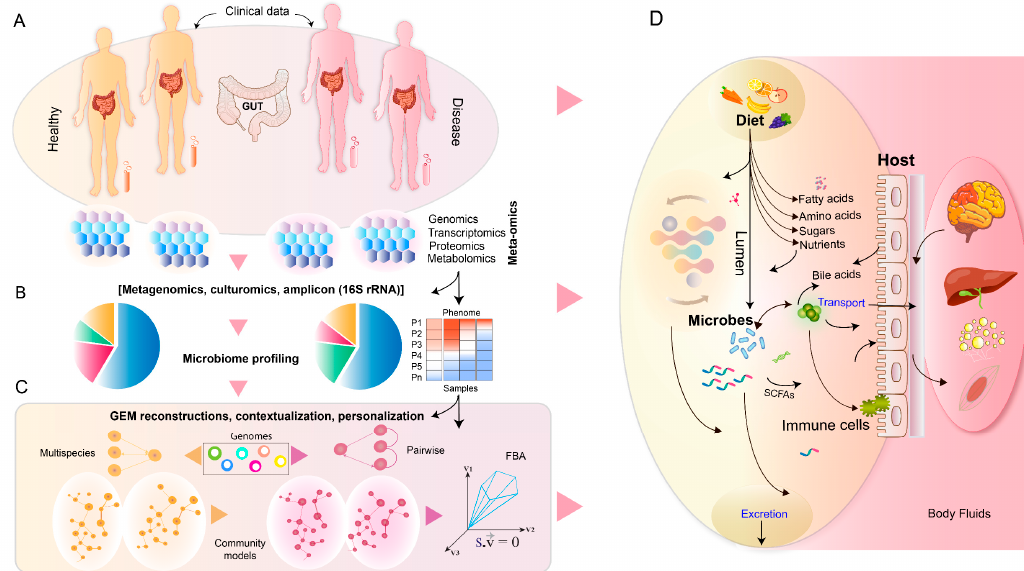
Figure 1. Overview of meta-omics profiling, annotation and genome-scale metabolic reconstructions. ( A ) Fecal, plasma and/or serum samples are taken from healthy and diseased subjects and meta-omics data is generated from these. ( B ) Taxonomic and functional profiling of gut microbes. ( C